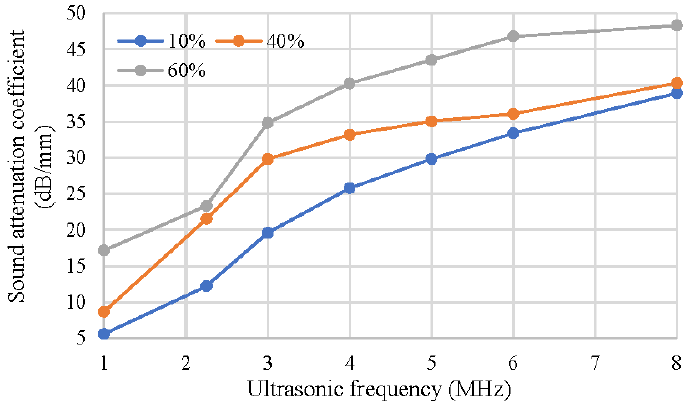
Figure 12. Ultrasonic attenuation coefficient of the different particle volume fractions with an ultra-